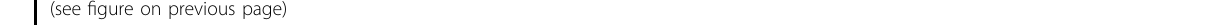
Fig. 4 Single base-scale methylated positions with average and variability. a Venn diagrams with the number of differentially methylated CpGs (DMCs) and differentially variable CpGs (DVCs). b The distribution of balanced error rates of classi fi cation using DMCs or DVCs. Signi fi cance levels were estimated from permutation test with 999 Monte Carlo replications. c The largest subnetwork is linked to response to wounding, tissue development, and collagen fi bril organization. Yellow areas denote where DMCs or DVCs are concentrated. Colors in large boxes represent gene expression levels in RA relative to OA. Red is upregulated, and green is downregulated. Stacked bar plots represent the number of DMCs or DVCs in certain genes. DMCs are colored red (hypermethylated) and blue (hypomethylated), while DVCs are colored orange (hypervariable) and green (hypovariable). d The second largest subnetwork is related to TGF- β receptor signaling